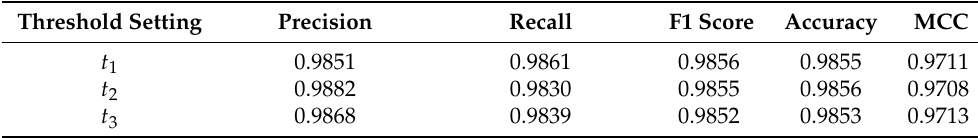
Figure 3. The ROC curve and AUC value of Validation Experiment B. Table 3. The result of Experiment B in terms of the Precision, Recall, F1 Score, Accuracy, and MCC